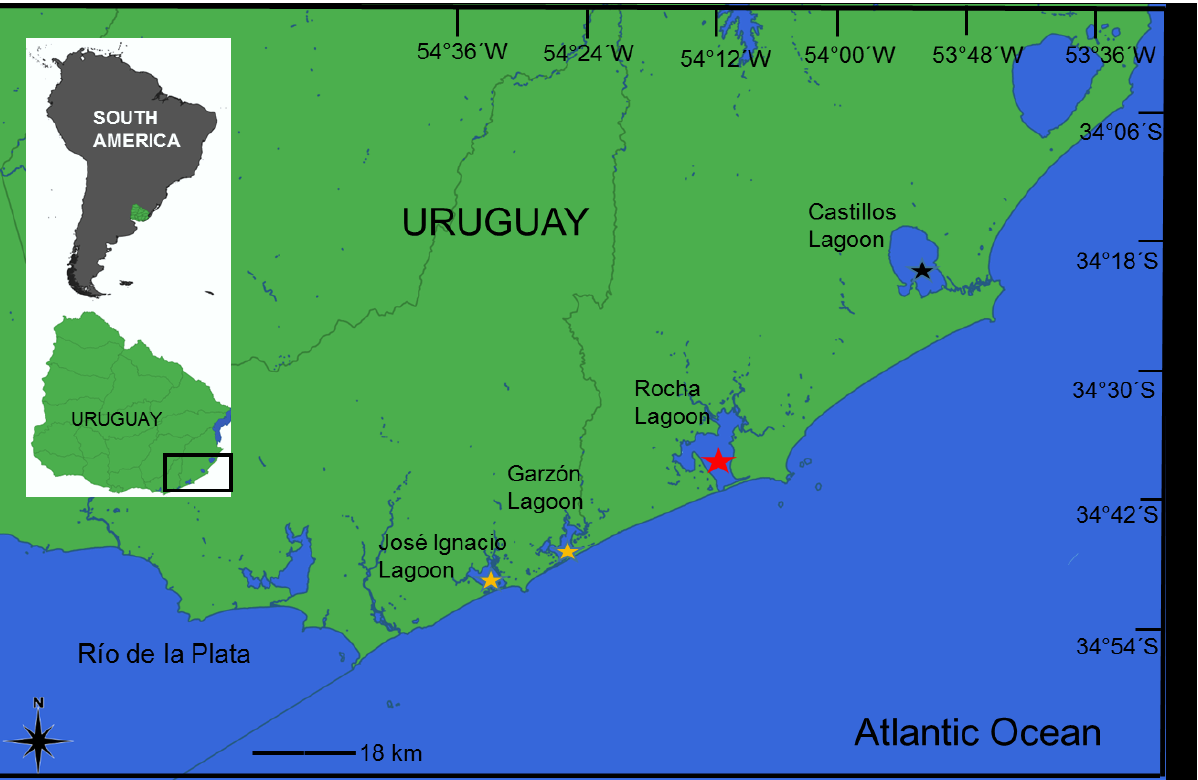
Figure 1. Map of the study area, indicating the location where the specimens of Farfantepenaeus brasiliensis and F. paulensis were recorded. Yellow stars: sites where F. brasiliensis and F. paulensis specimens were initially recorded. Black star: only F. paulensis specimens were recorded. Red star: site where complete sampling and analyses of both species were carried out in April 2019. The location of the study area at the regional level is shown in the upper left